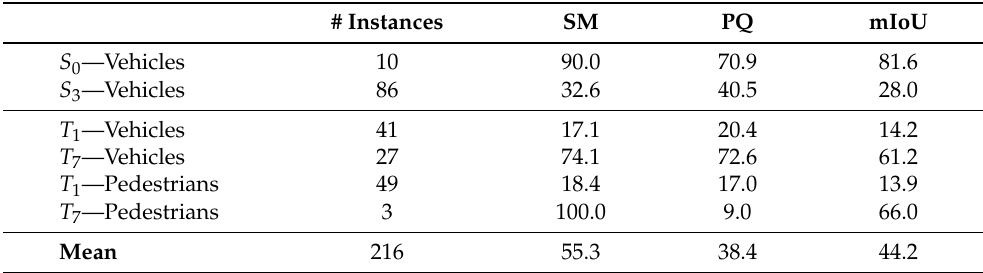
Table 5. Results on test sets of Paris-CARLA-3D for the instance segmentation task. SM: Segment Matching. PQ: Panoptic Quality. mIoU : mean IoU. All results are in %.